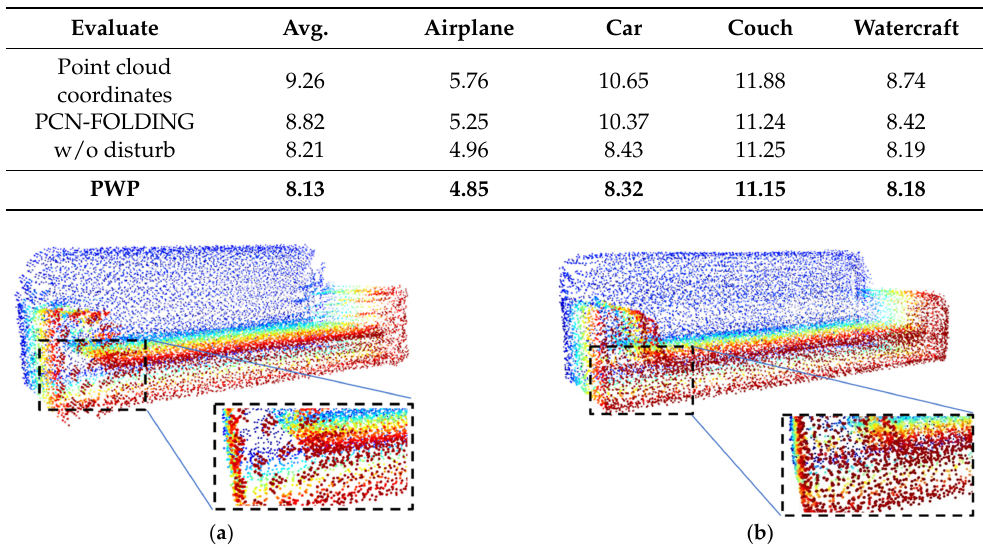
Table 7. Analysis and comparison of PWP in the point cloud growth module in terms of per-point chamfer distance (CD) with L1 norm computed on 16,384 points and multiplied by 10 3 . The best results are highlighted in bold (lower is better).